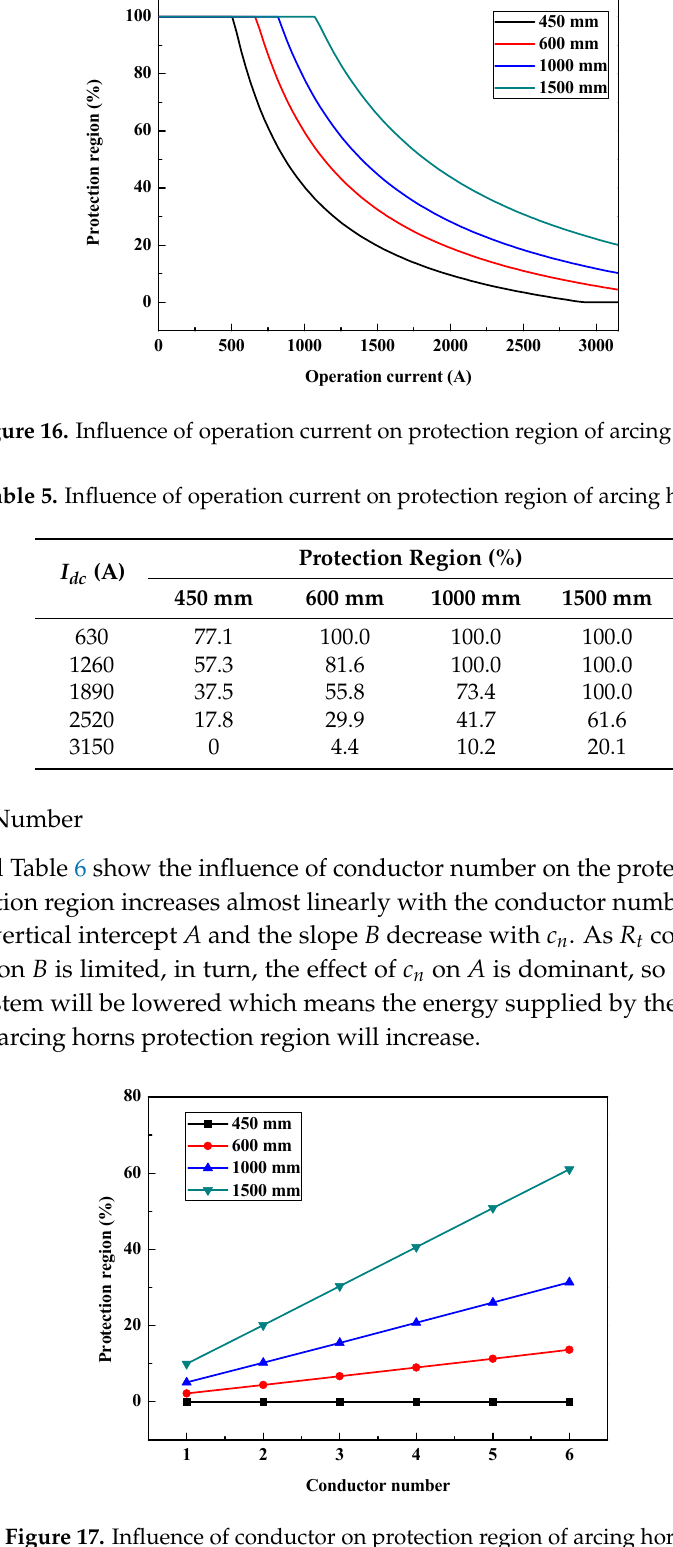
Figure 17. Influence of conductor on protection region of arcing horns.